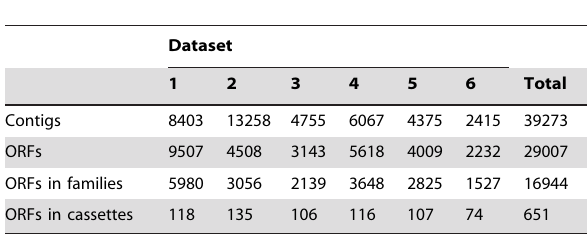
Table 1. ORFs in families and cassettes. Table 2. Contigs and reads that form